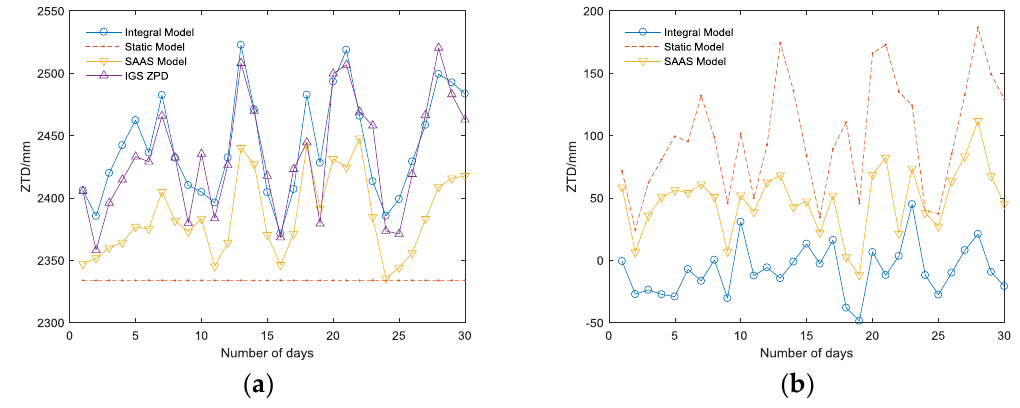
Figure 3. ( a ) The IGS ZPD variations and ZTD variations of the three models in June; ( b ) The difference value (DIFF) between ZTD of three models and IGS ZPD in June. SAAS: the Saastamoinen model.